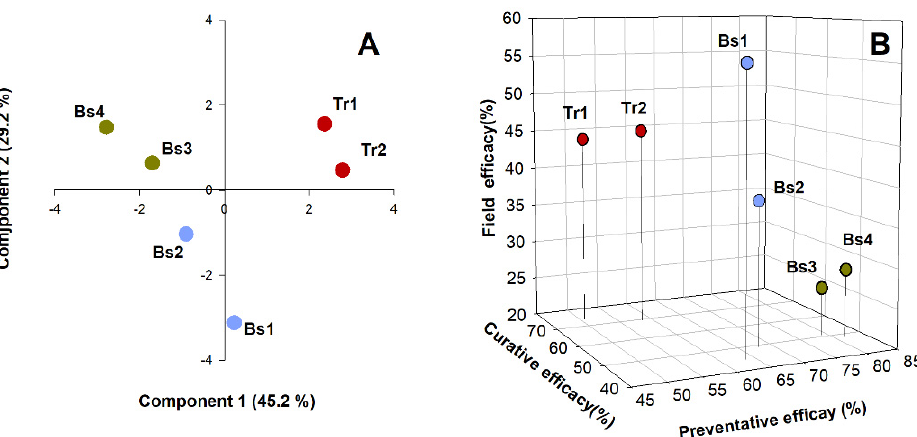
Figure 6. ( A ) Principal component analysis score plot (component 1 versus 2) of six biological control agents. Eleven variables were included in the analysis. Biological control agents used were Bacillus subtilis strains (Bs1, Bs2, Bs3, Bs4) and Trichoderma spp. strains (Tr1, Tr2). ( B ) Global efficacy obtained when the BCAs were applied preventatively, curatively, and in field trials were represented for each one. Average data of 17 independent experiments were used.